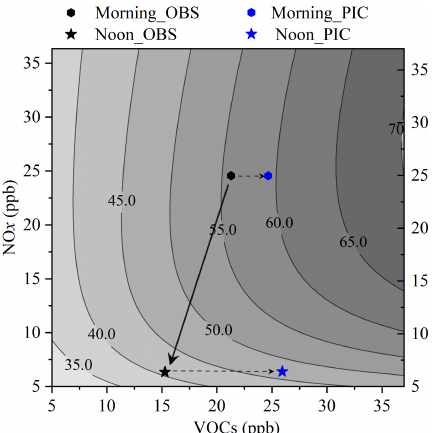
Figure 2. Isopleth diagram of the ozone concentration as a func- tion of the concentration of NO x and VOCs derived from an empir- ical kinetic modelling approach. The pentagons and stars indicate the status in the morning (09:00–10:00LT) and at noon (14:00– 15:00LT), respectively. The black and blue colors represent the ob- served and corrected statuses,